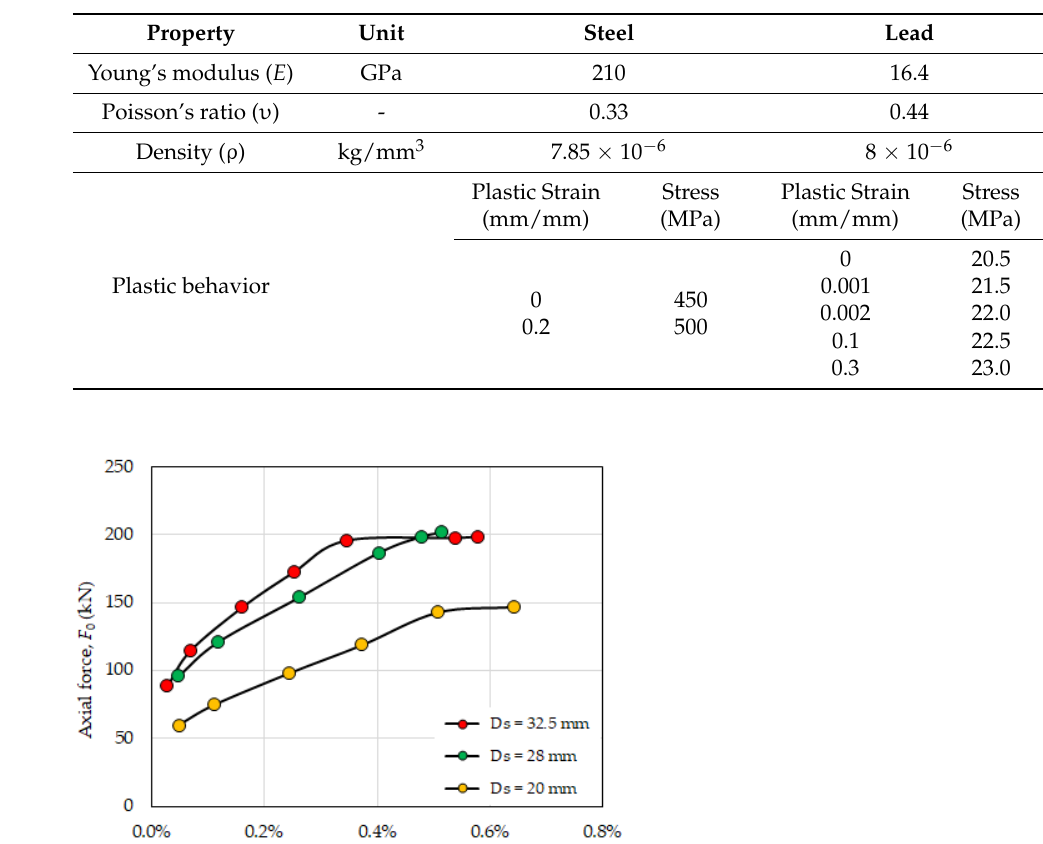
Table 1. Material properties used in the FE model [12].